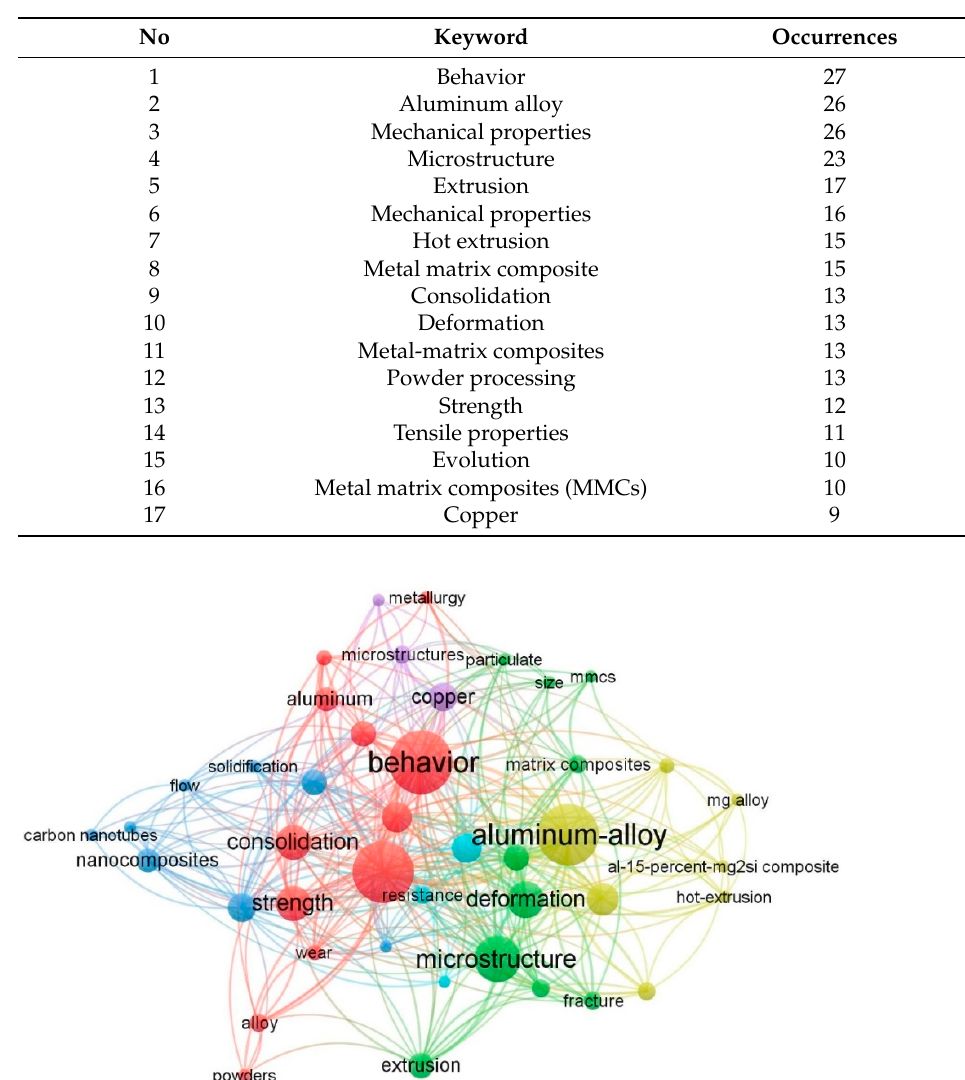
Table 12. Keywords emerged from the analysis.